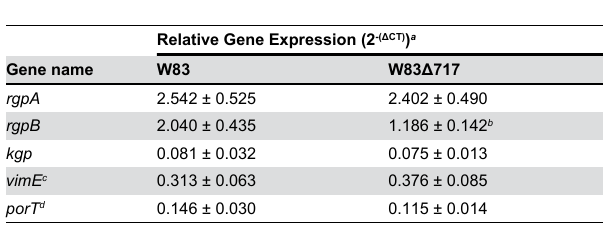
Table 2. Expression of gingipain genes as measured by